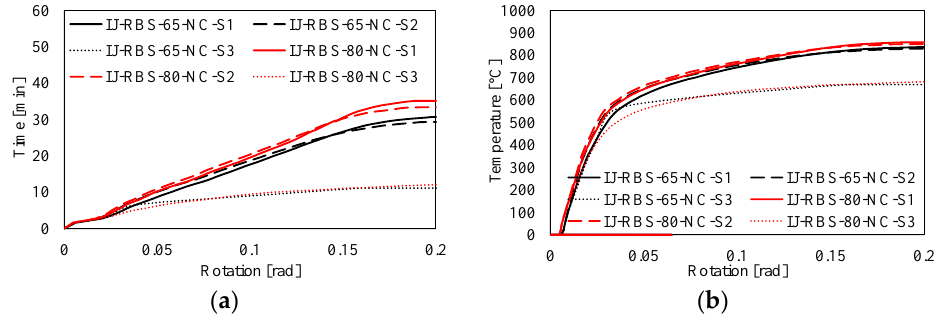
Figure 13. Comparison between the RBS configurations in the S1, S2, and S3 fire scenarios in terms of time-rotation ( a ) and temperature-rotation curves ( b ).